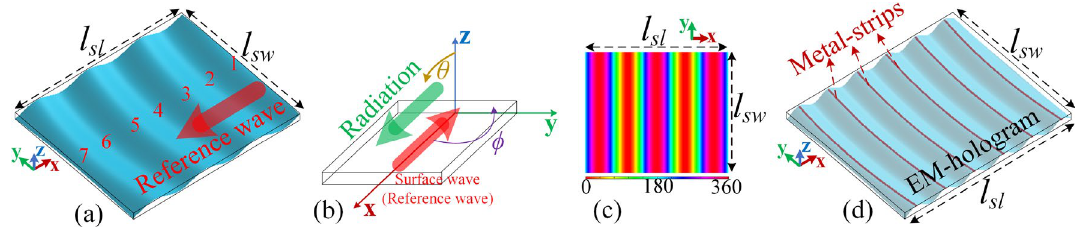
Figure 11. Applying holography technique on the Rogers RT/duroid 6010 dielectric slab; ( a ) the quasi-planar reference wave on the structure, ( b ) the dielectric slab and the direction of intended radiation in a standard right-handed coordinate system, ( c ) object wave’s phase lines map on the structure, ( d ) calculated EM-hologram and the corresponding metal-strips pattern, named as the surface-waves recycler